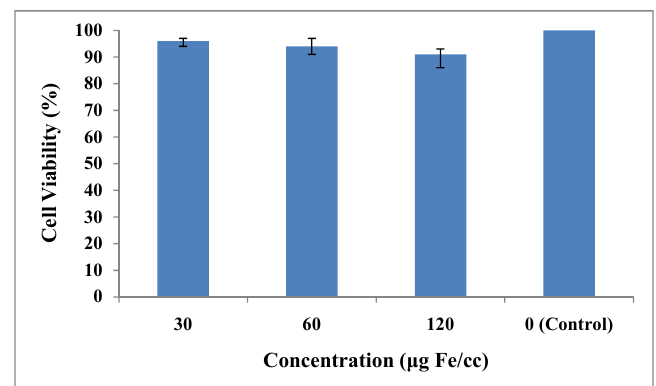
Fig. 6. Viability of Hela cells after 4 h incubation with sample A, verifying the acceptable biocompatibility of over 91% in all